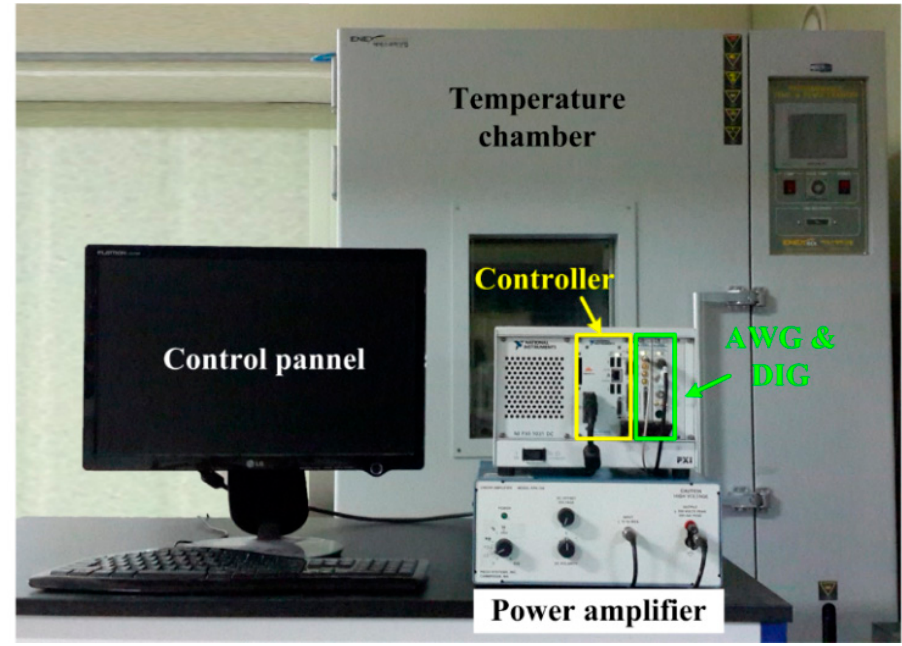
Figure 7. Creation of a fatigue crack through cyclic loading tests: ( a ) Tensile-loading test setup with a specimen and ( b ) Microscopic images and crack widths. UTM: universal testing machine.